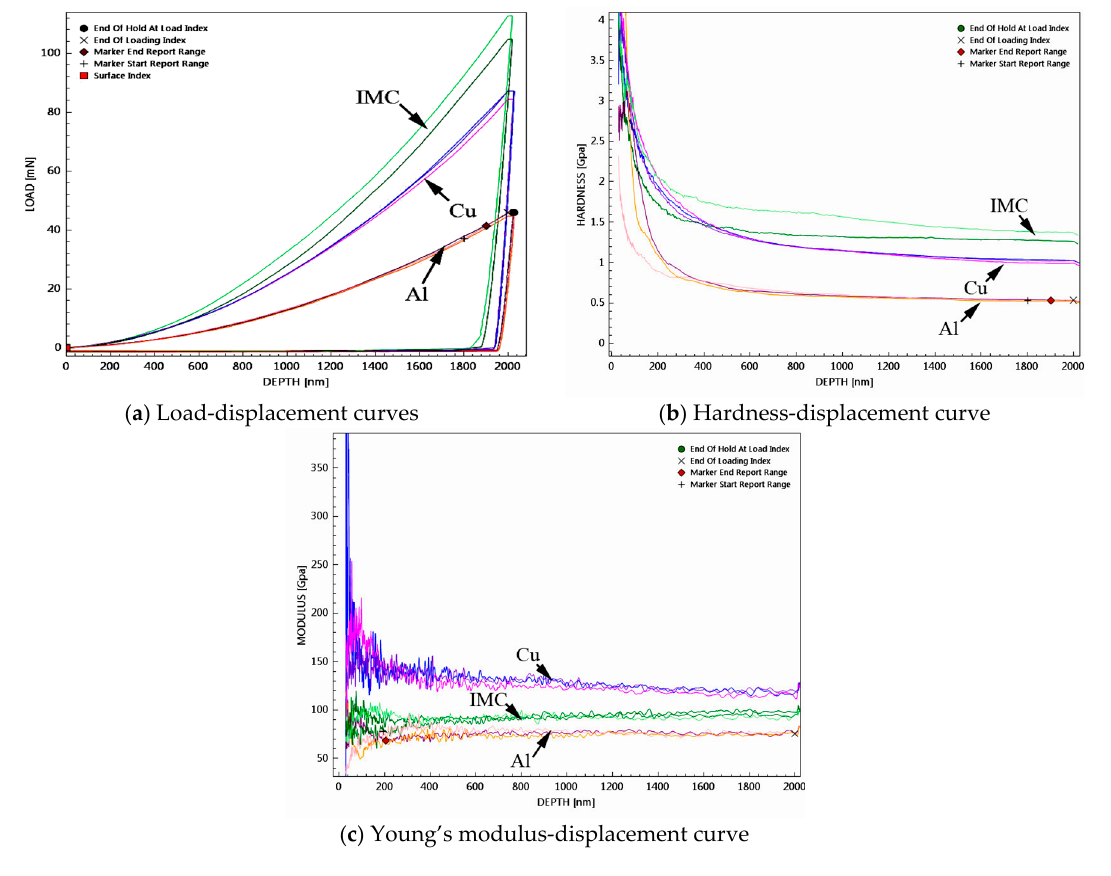
Figure 9. Result of nanoindentation test.